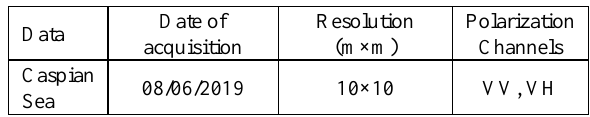
Table 3 . The description of the SAR image.